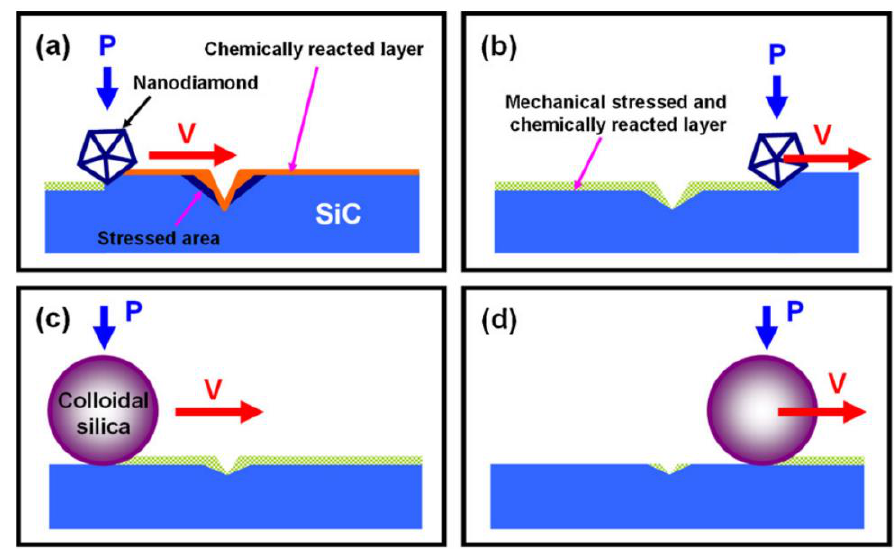
Figure 7. Probable mechanism of scratch removal in MAS CMP: ( a ) chemically reacted surface of SiC; ( b ) the SiC surface after chemically reacted layer removed by nanodiamonds; ( c ) the mechanical stressed and chemically reacted layer before removed by colloidal silica; ( d ) the SiC surface after chemically reacted layer removed by colloidal silica [26].